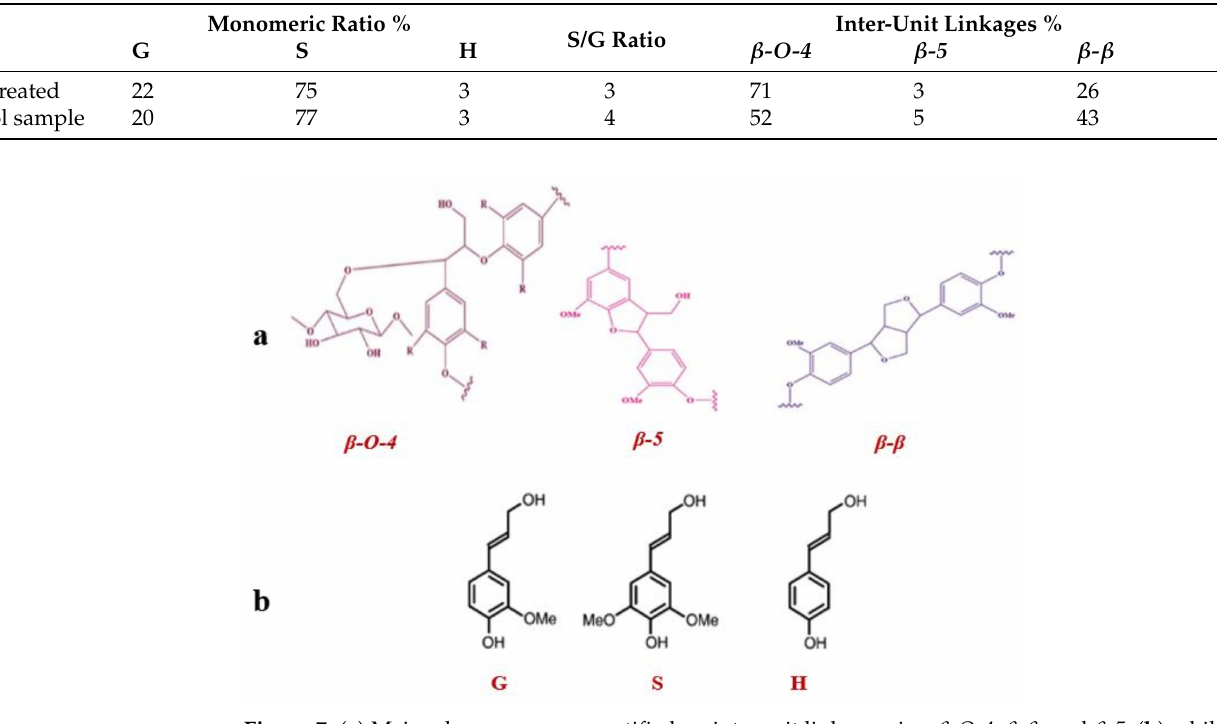
Figure 7. ( a ) Major changes were quantified on interunit linkages, i.e., β -O-4 , β - β , and β -5, ( b ) while small changes were seen on the main substructures G (coniferyl alcohol), S (sinapyl alcohol), and H (p-coumaryl alcohol) in the APL after the ScLac treatment. Table 5. Signal assignments of the 13 C– 1 H correlation peaks in the 2D HSQC NMR spectra of the isolated lignin fractions, according to Sette et al. and Zikeli et al. [41,42]. δ C / δ H